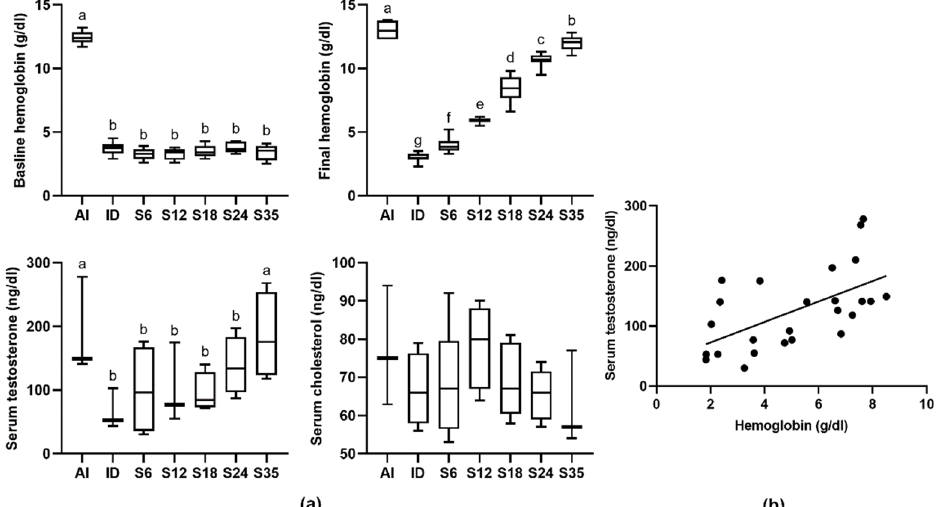
Figure 2. Effects of different doses of iron supplementation on ( a ) blood hemoglobin, testosterone, and cholesterol levels, and ( b ) the relationship between blood hemoglobin and testosterone levels in iron-deficient rats. Values are presented as median (interquartile range, IQR). n = 4–8 per group. Values not sharing the same letters are significantly different at p < 0.05. Baseline: after 3-week iron depletion and before iron supplementation; Final: after 2-week iron supplementation.